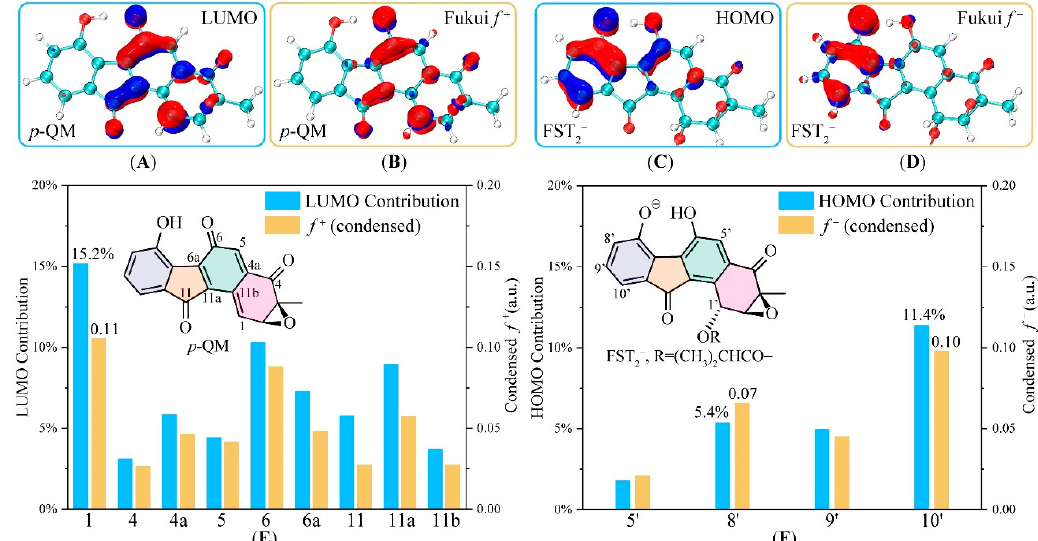
Figure 4. Prediction of the C–C coupling regioselectivity by frontier molecular orbitals (FMO) and Fukui function (FF). ( A , B ) Isosurface of the LUMO and Fukui 𝑓 (cid:2878) of electrophile p -QM , respectively; ( C , D ) those of the HOMO and Fukui 𝑓 (cid:2879) of nucleophile FST 2 − (FMO: isovalue = ±0.05 a.u., FF: isovalue = ±0.002 a.u.); ( E , F ) Comparison of FMO coefficients and condensed FF for p -QM and FST 2 − , respectively. The orbital interaction in the Michael addition is likely to be dominant by the HOMO–LUMO interaction. Isosurface of Fukui function mimicked the special electron density changes in the reaction. The electron flow to nucleophile p -QM increases its electron density near C1, C6, C6a, C11, and C11a, in perpendicular direction to the conjugated aromatic ring. The electron flow from FST 2 − is also perpendicular to its conjugated aromatic ring. This is consistent with the expectation that FST 2 − HOMO electrons would transfer to the LUMO of the recipient molecule, in a face-to-face fashion through the vertical space. The HOMO–LUMO orbital interaction between the nucleophile and electrophile is consistent with π – π stacking interaction between the two 6-5-6 fused aromatic rings.